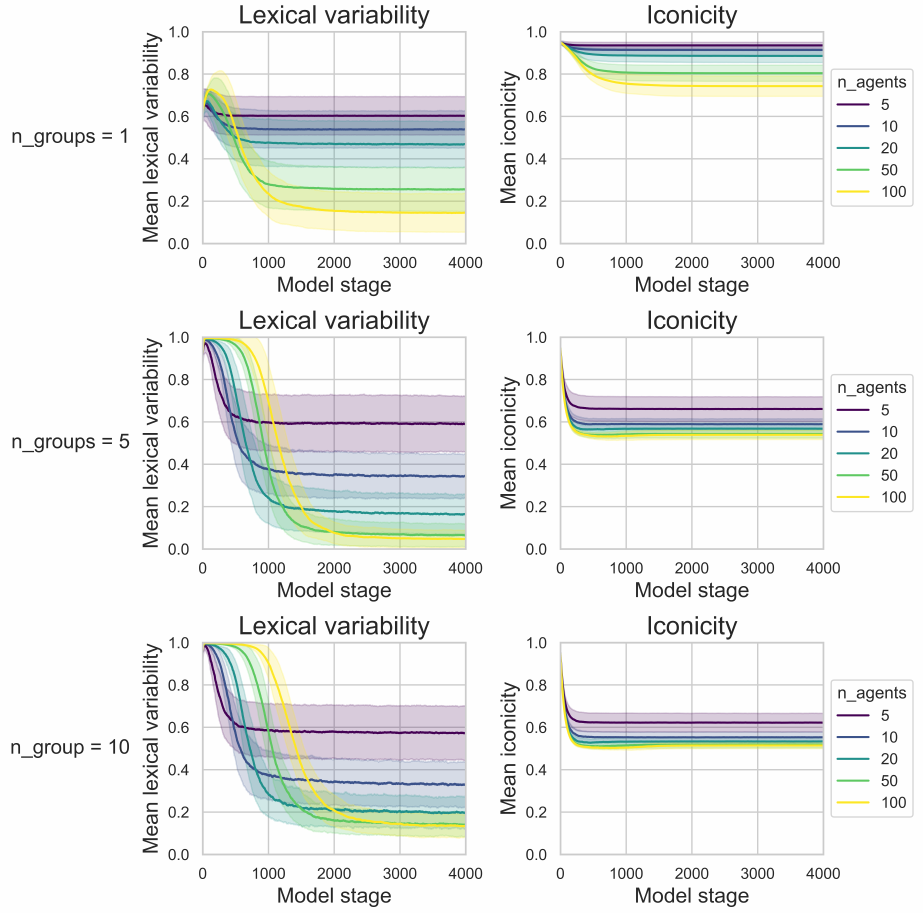
Figure 11. The mean lexical variability over 4000 model stages for different population sizes ( n_agents ), showing three different group values ( n_groups ) determining the sets of culturally salient features of the agents. The dark line represents the mean and the shaded area represents the standard deviation of the 100 repetitions. Regardless of the number of groups, it is clear that the larger population sizes exhibit a lower mean lexical variability than small population sizes. In addition, when there are more agents, the level of iconicity is